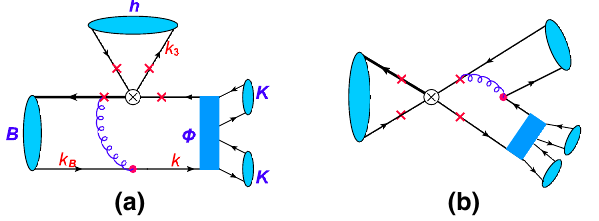
B + , B 0 , B 0 s , the final states K ± , K 0 , ¯ K 0 and the bachelor state of the pion or kaon, respectively, and k B , k and k 3 are the momenta for the spectator